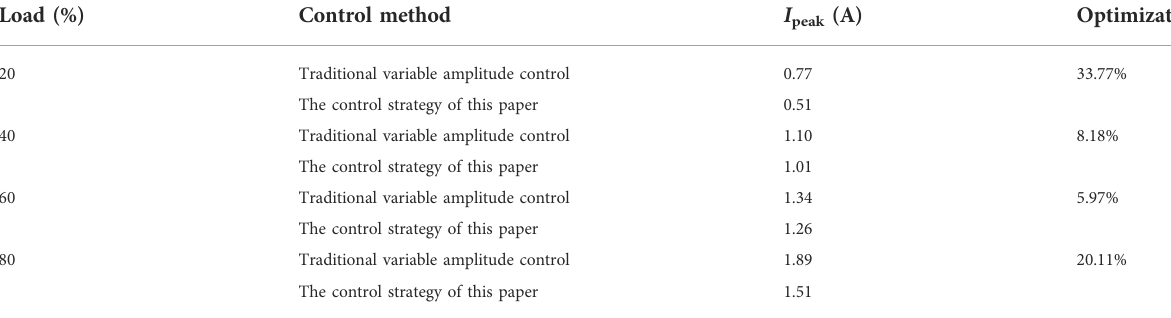
TABLE 4 Comparative analysis of current stress with rated power of 100W Load (%)